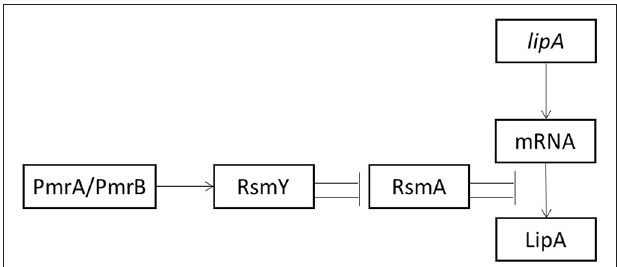
FIGURE 6 | Schematic diagram of activation of lipA expression by the Pmr-Rsm system in P. aeruginosa PAO1. Arrow, positive effect; bar, negative